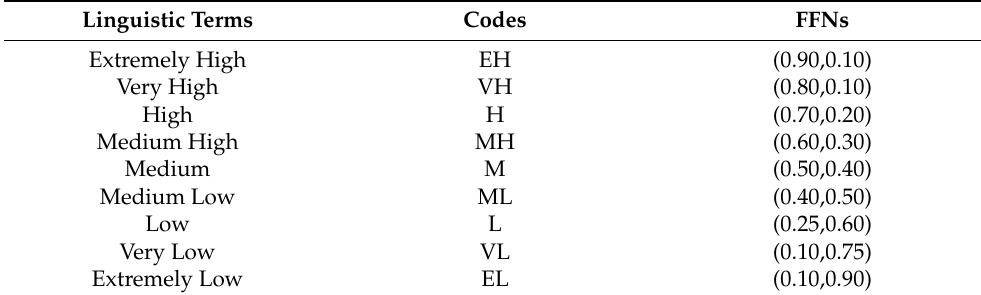
Table 6. Linguistic Terms for Evaluating